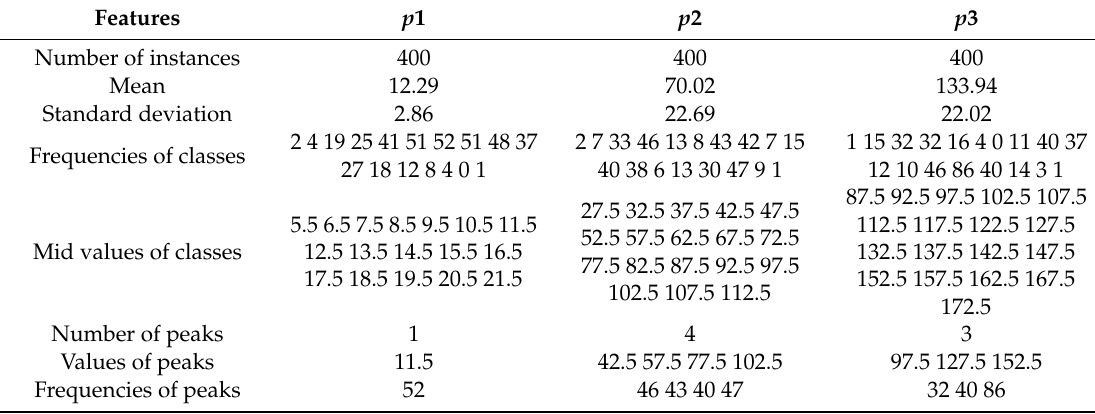
Table 2. Descriptive statistics and frequency polygon data of the features in 3P_4C dataset.